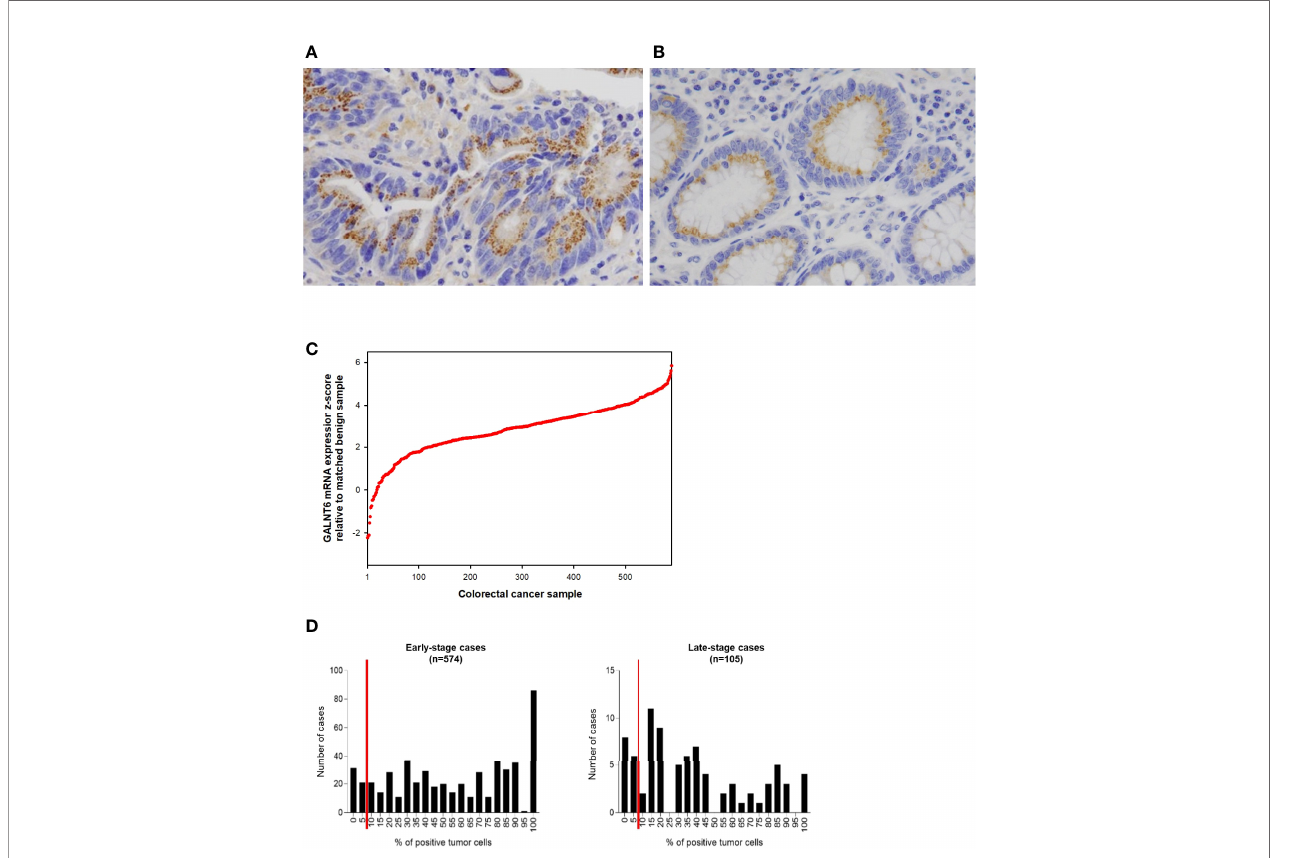
FIGURE 2 | Examples of (A) a case of colorectal adenocarcinoma with high % of tumor cells expressing GALNT6 protein and (B) of GALNT6 protein expression in normal/benign colonic mucosa. GALNT6 proteins are colored brown with nuclei counterstained in blue. (C) GALNT6 mRNA z-scores of colorectal adenocarcinomas (relative to matched benign mucosa) from the TCGA cohort sorted in ascending order (a positive z-score corresponds to higher transcript expression in the cancer relative to matched normal). (D) Distribution of GALNT6 protein expression (% of tumor cells staining positive) in colorectal cancer. Tissues with ≥ 10% of tumor cells with GALNT6 immunohistochemical staining are considered positive (red lines show cut-off). There are fewer GALNT6-negative cases among early stage (stages I and II, 9.9% of cases) vs. late stage (stages III and IV, 15.2% of cases)